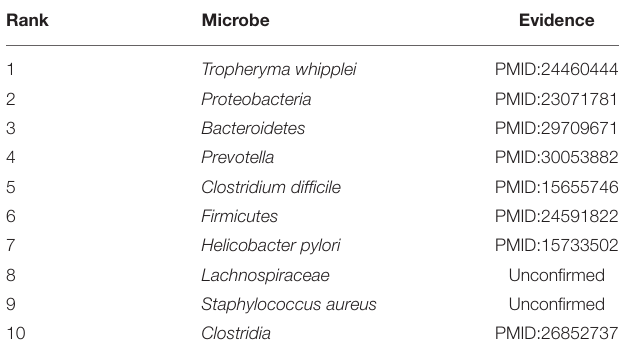
TABLE 6 | Top 10 potential COPD-related microbes predicted by BWNMHMDA and 8 out of these 10 microbes have been confirmed by evidences.